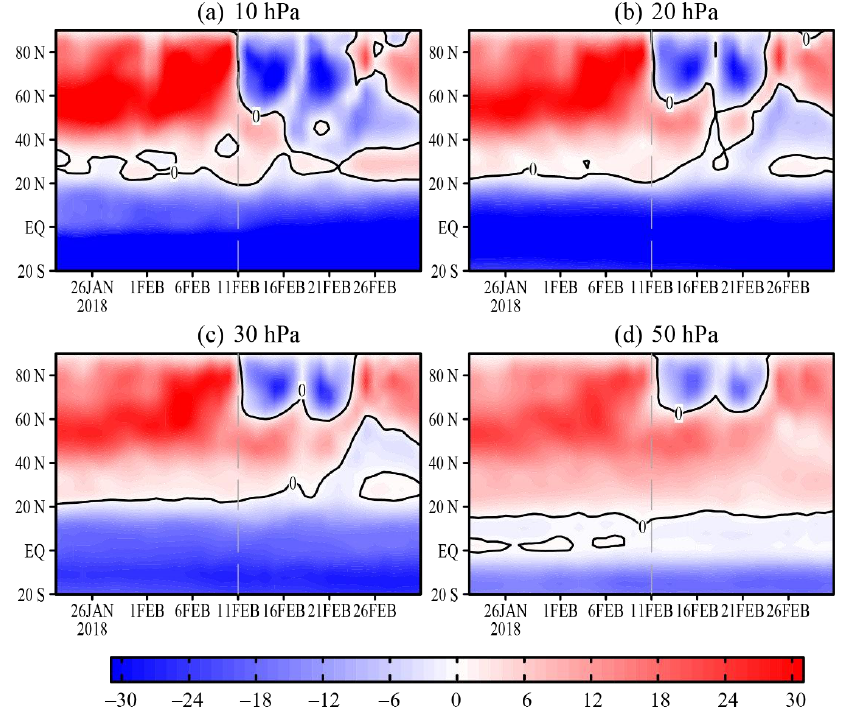
Figure 3. The latitude–time cross sections of the zonal-mean zonal wind (unit: m s − 1 ) during the period 22 January–3 March 2018 at ( a ) 10 hPa, ( b ) 20 hPa, ( c ) 30 hPa, and ( d ) 50 hPa, respectively.